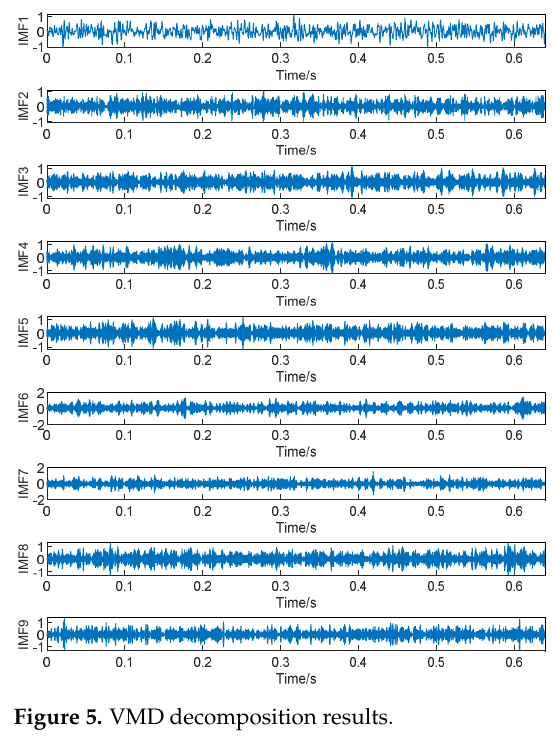
Figure 5. VMD decomposition results.